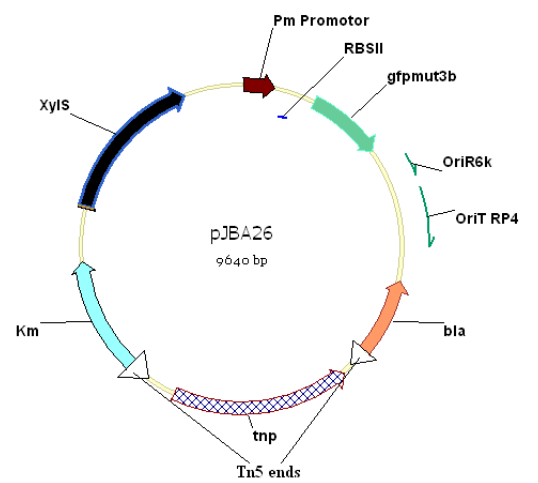
Figure 3. Genetic Map of pJBA26 vector [12], the region between the Tn5 ends from the kanamycin resistance gene (Km) to the β-lactamase gene (bla) can be transposed into the chromosome of suitable recipient cells such as Pseudomonas